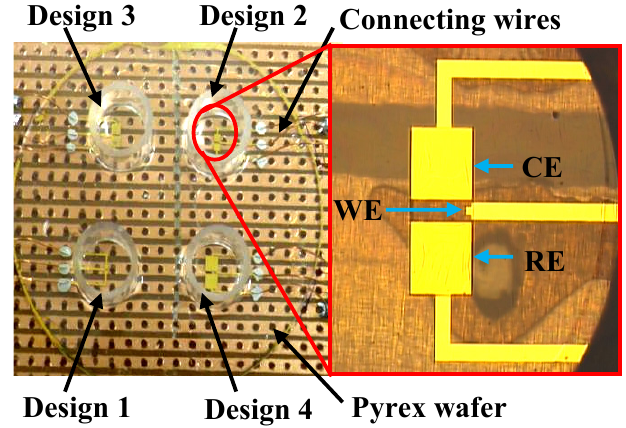
Fig.1: Microphotograph of different three-electrode devices.